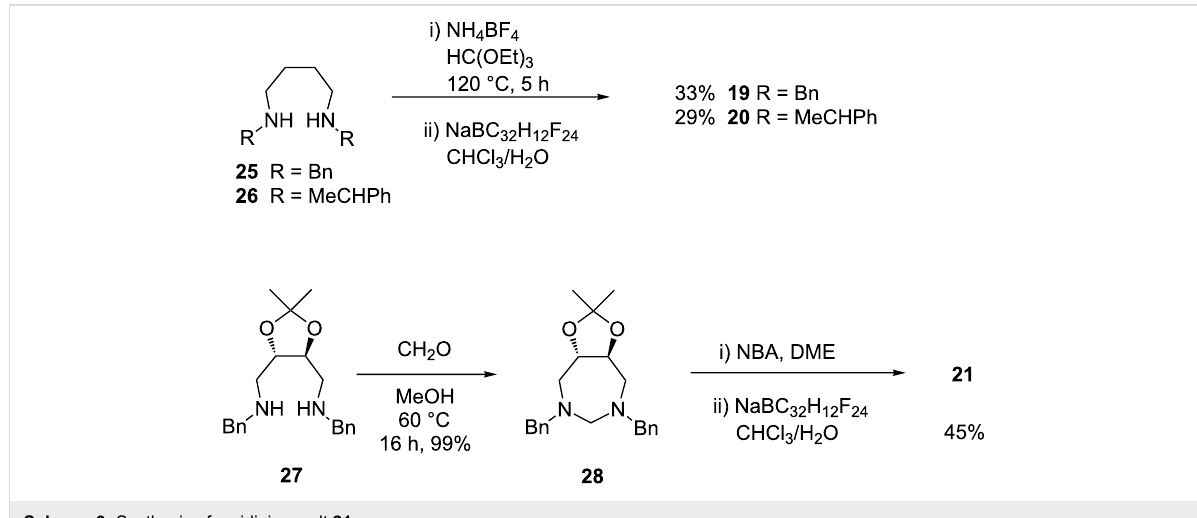
Scheme 6: Synthesis of amidinium salt 21